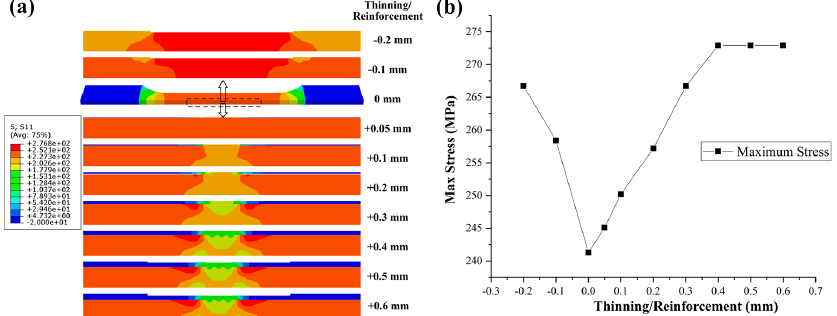
Figure 10. Comparative stress analysis under different thinning amounts and reinforcements: ( a ) comparison of stress distribution map and ( b ) comparison of maximum stress.